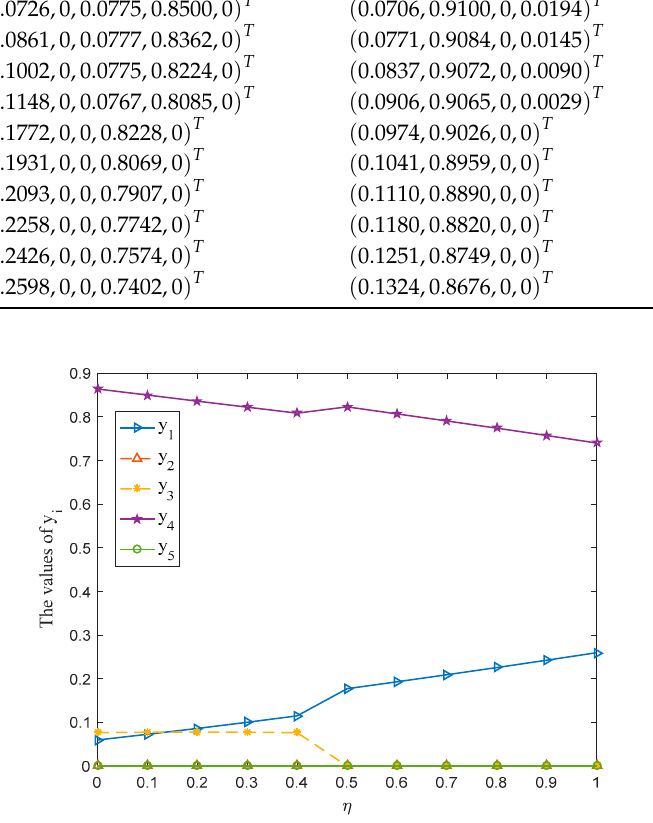
y with parameter η varying from 0 to1. Figure 8. y Figure 8. i with parameter η varying from 0 to i